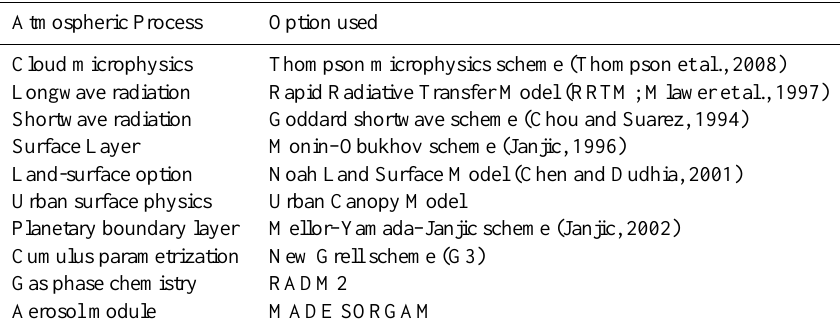
Table 1. The WRF-Chem options used in the present